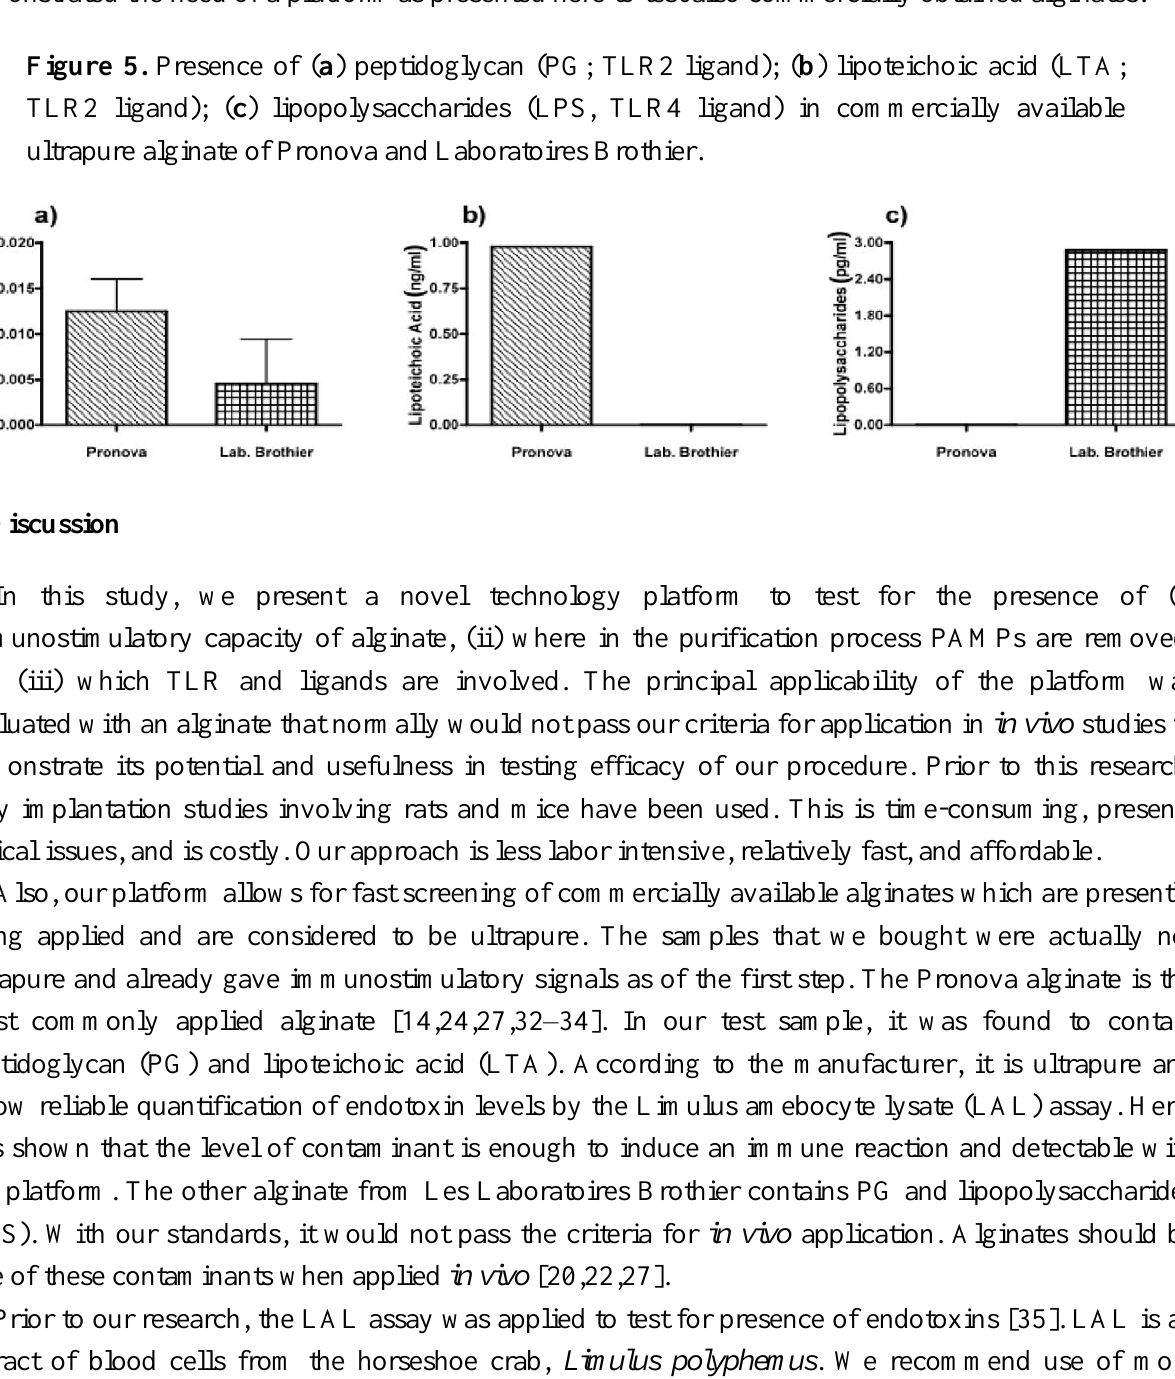
Figure 5. Presence of ( a ) peptidoglycan (PG; TLR2 ligand); ( b ) lipoteichoic acid